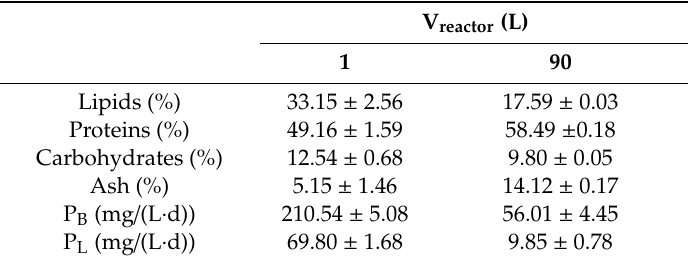
Table 7. Biomass analysis for the 1-L bottle culture and the 90-L scale.